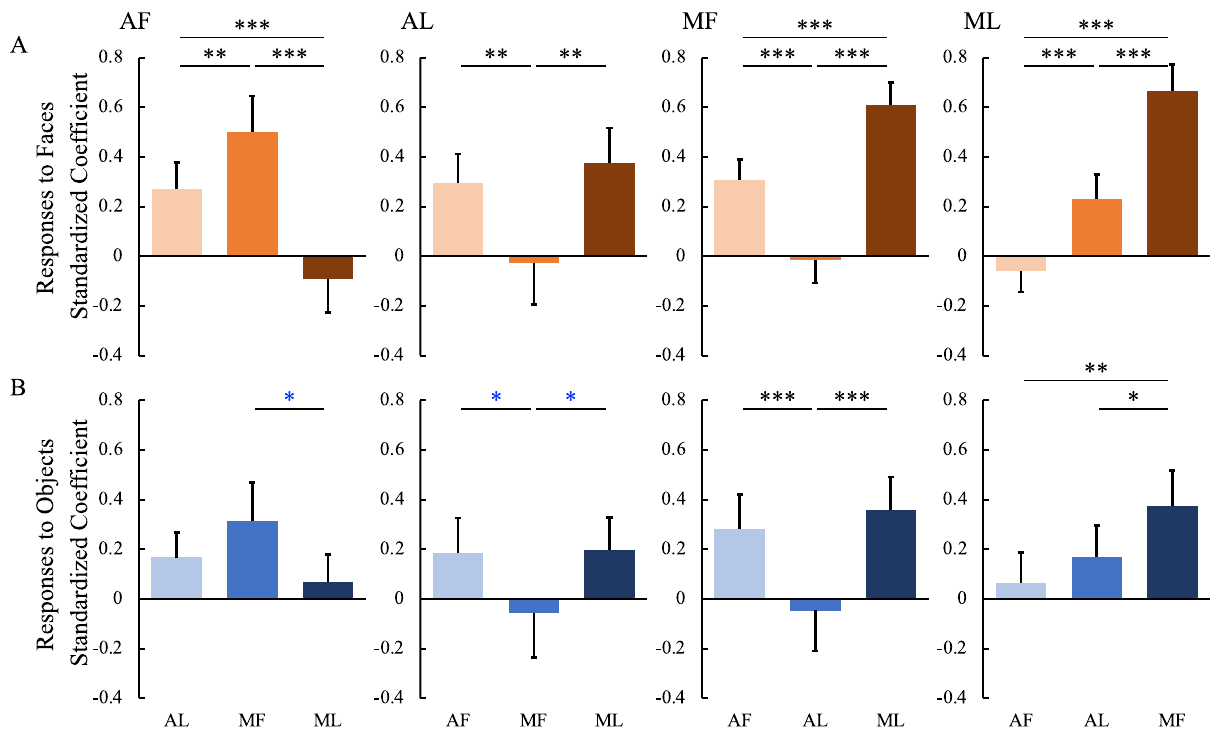
Fig. 8 | Functional relationships among the temporal face patches. Standar- dizedbeta-coef fi cientsforlinearregressionwithresponsestofaces( A )andobjects ( B ) in one face patch (the name is shown at the top left of each panel) as outcome and responses to faces/objects in the rest of the face patches as predictors (the nameisshownasthehorizontalaxislabelsatthebottomofeachcolumn). P values